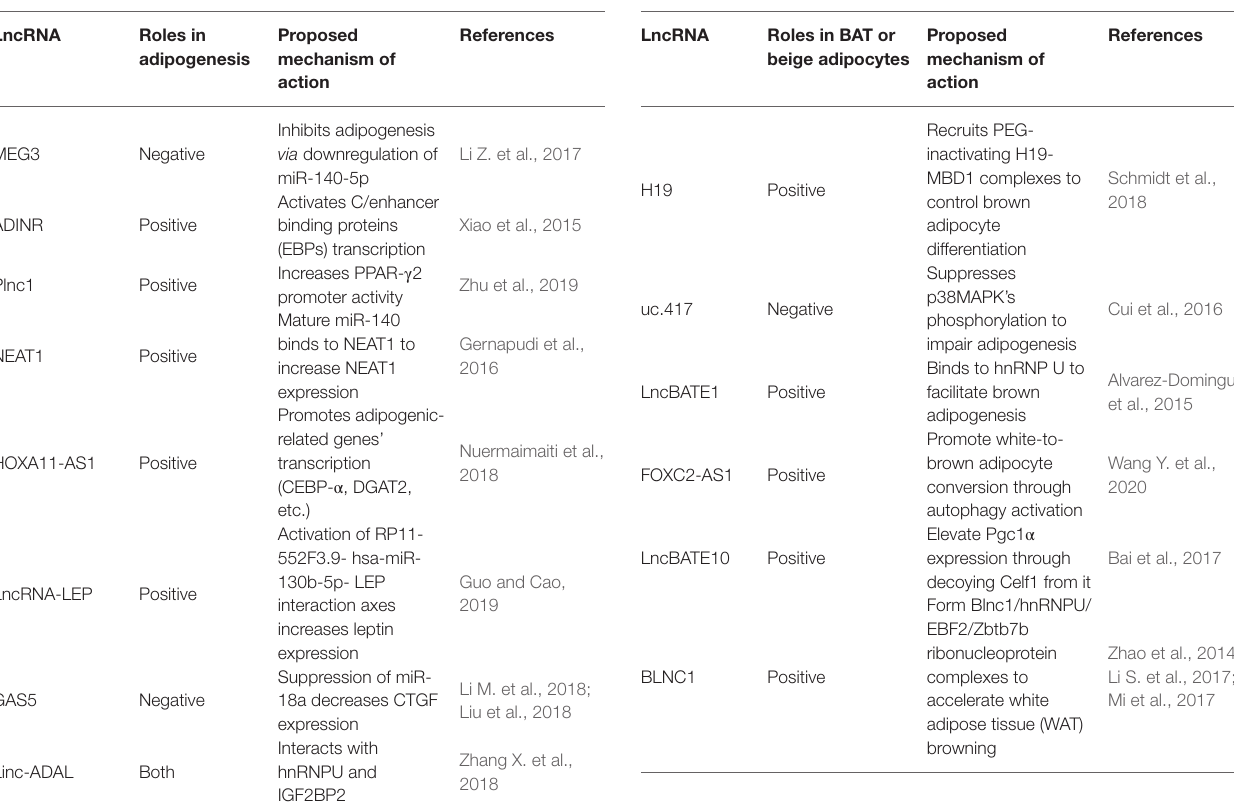
TABLE 3 | Key roles of LncRNAs in regulating brown/beige adipogenesis. TABLE 2 | Key roles of LncRNAs in regulating white